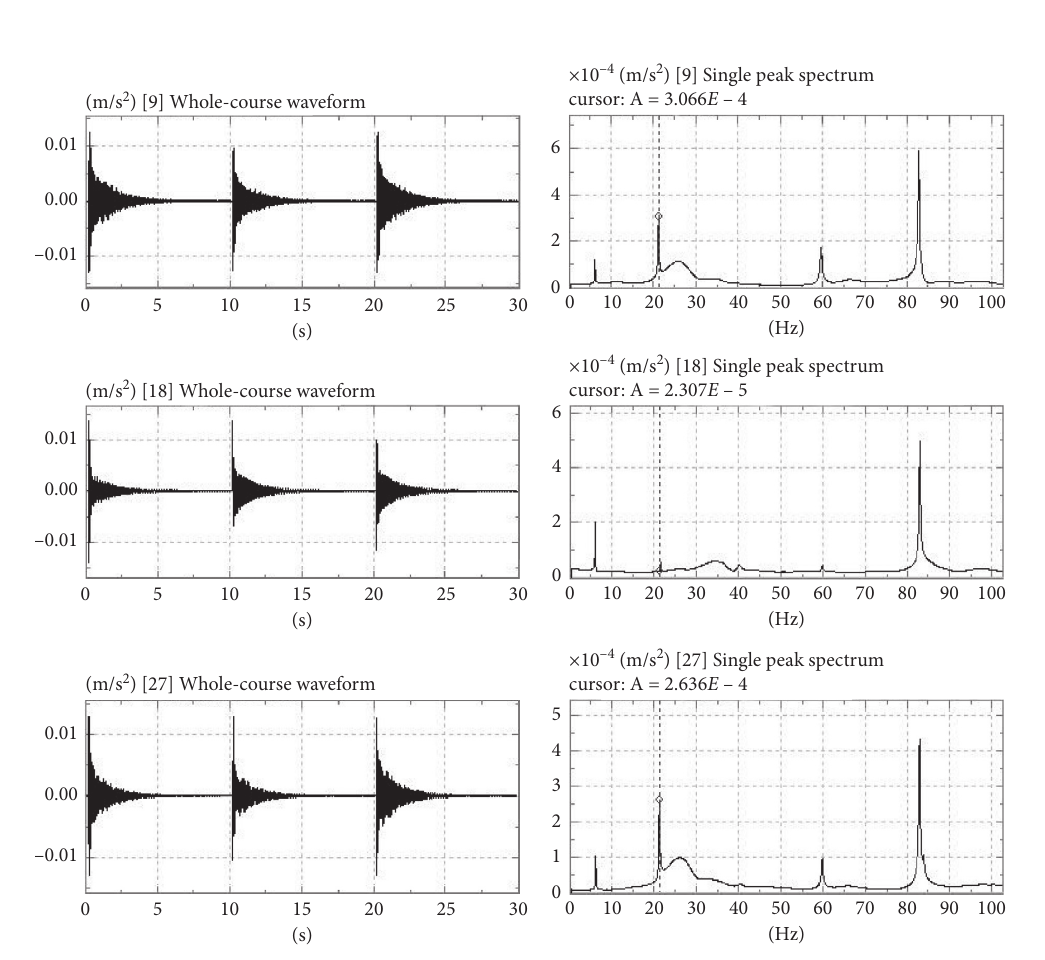
Figure 20: Spectrum curve of undamaged